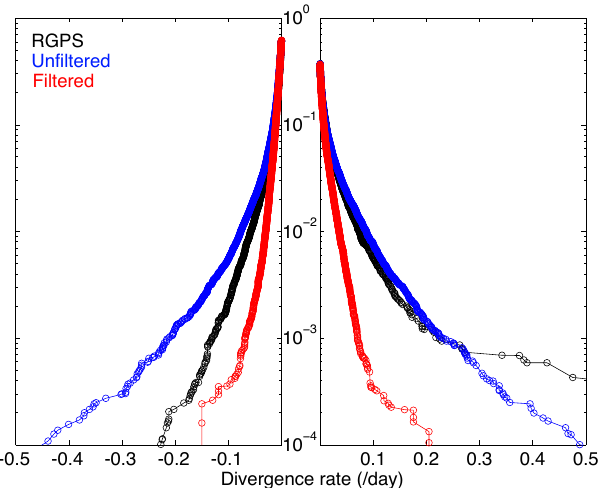
Figure 13. Cumulative probability functions – in other words, the probabilities of exceedance – for the RGPS, unfiltered and filtered composite divergence fields shown in Figs. 7–9,